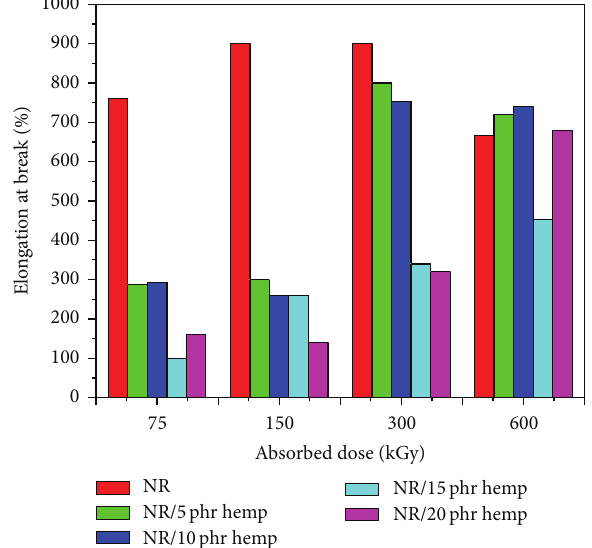
Figure 5: Elongation at break variation as a function of hemp amount and irradiation dose.